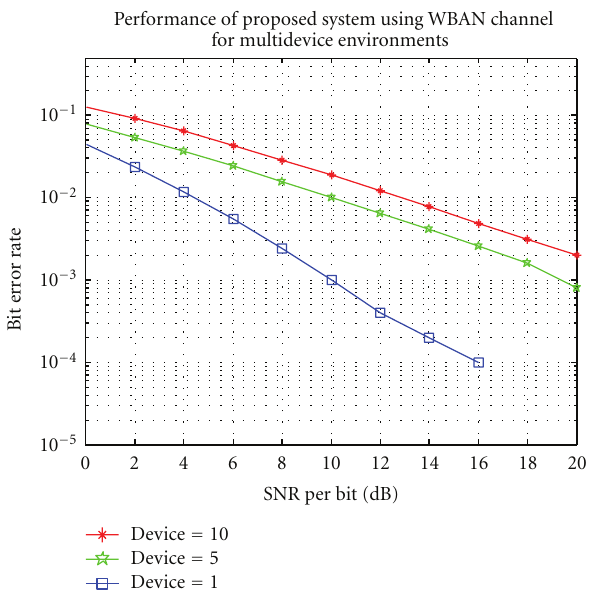
Figure 8: Performance of PPM TH UWB/MIMO (2 × 2) system using m-ZCZ codes for multidevice environments in WBAN channel.